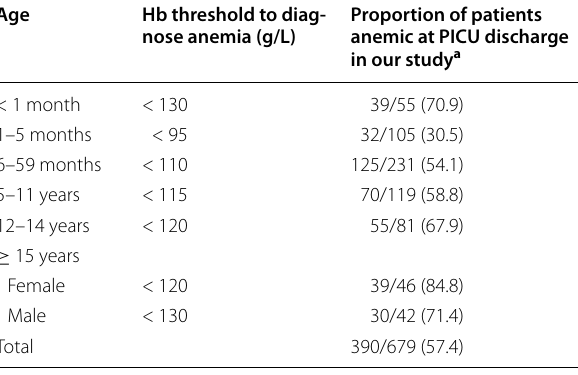
a Number of anemic children/total number of children in the age category (%) Hb hemoglobin, PICU pediatric intensive care